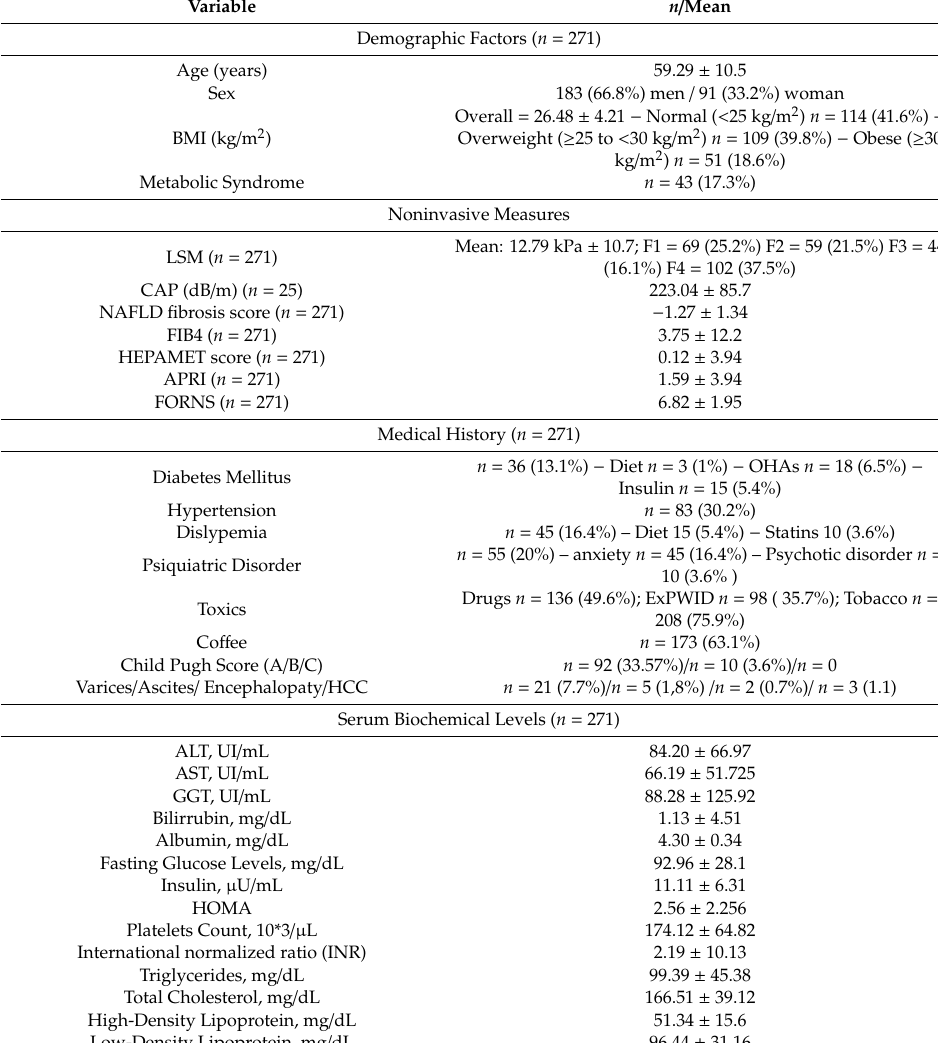
Table 1. Baseline demographics and clinical characteristics. Data are presented as no. (%) or mean ± standard deviation. Abbreviations: BMI, body mass index; ALT, alanine aminotransferase; AST, aspartate aminotransferase; GGT, gamma glutamyl transferase; HCC, hepatocellular carcinoma; INR, international normalized